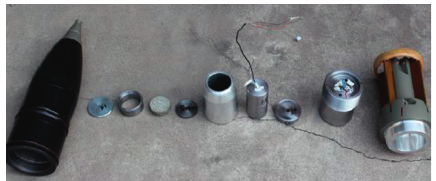
Figure 6: Physical drawing of the parts.